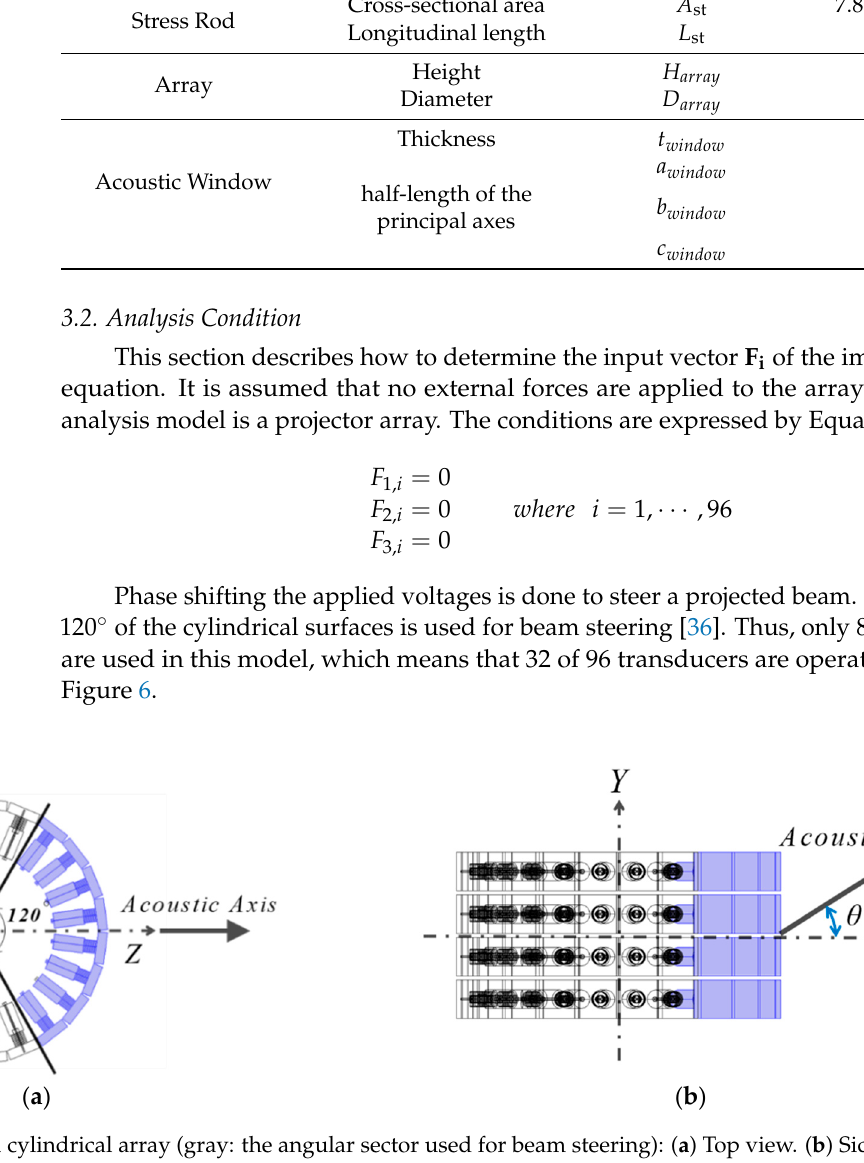
θ by phase shift-